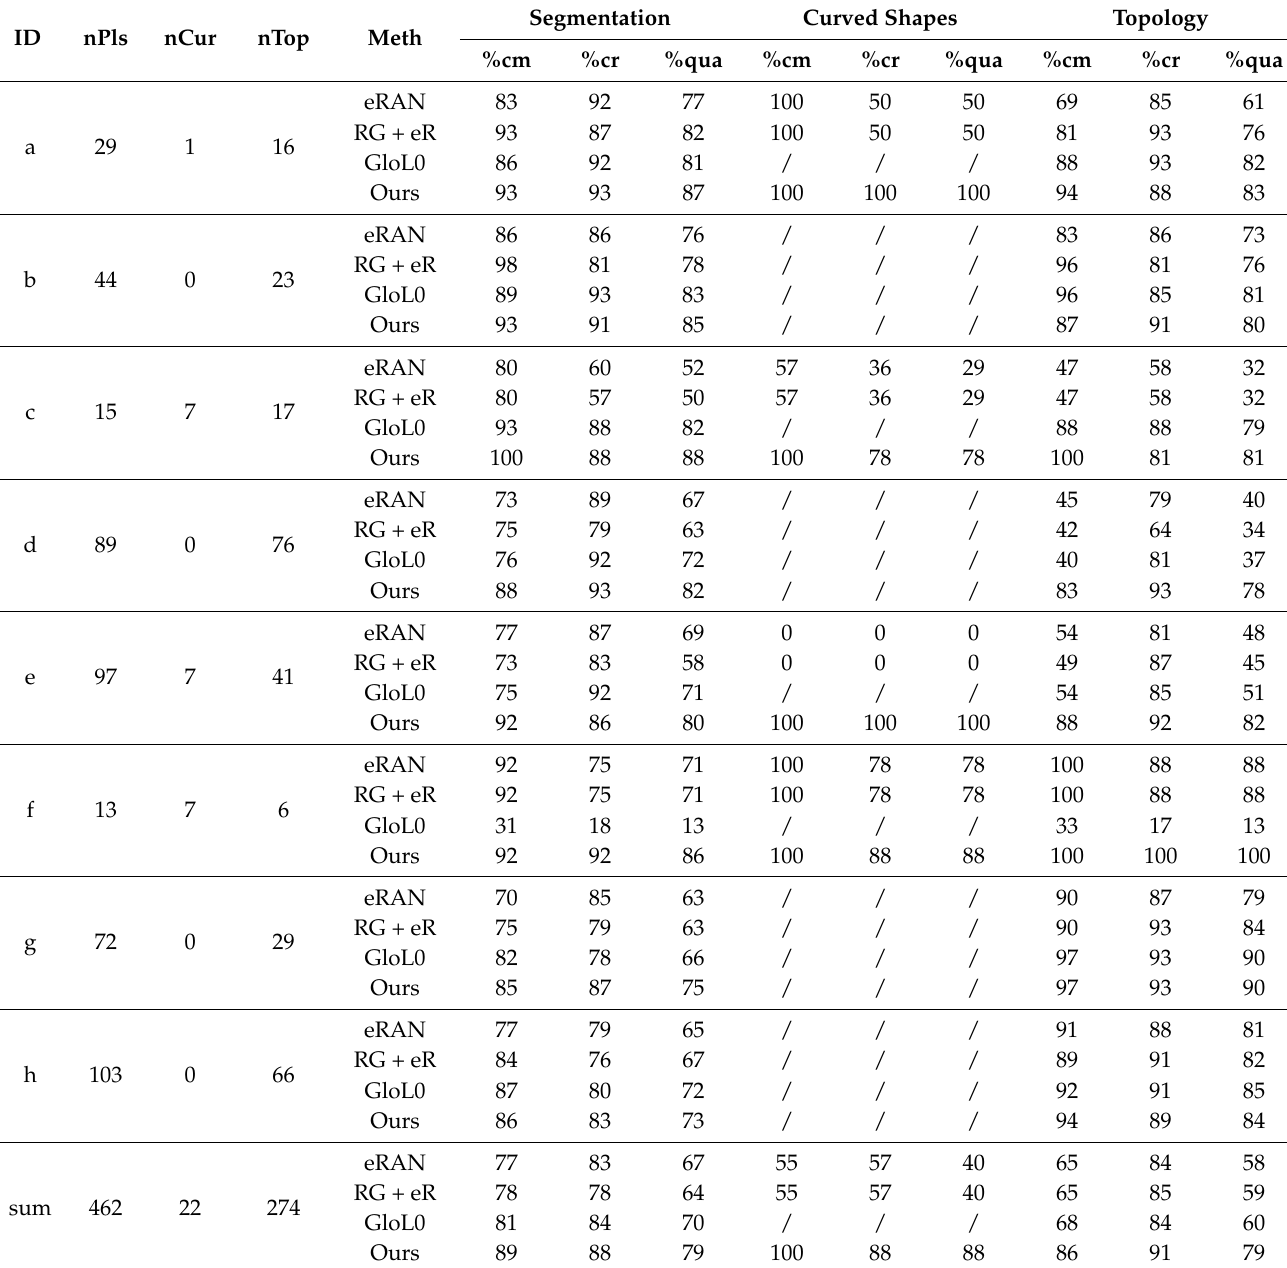
Table 4. Comparison of the segmentation